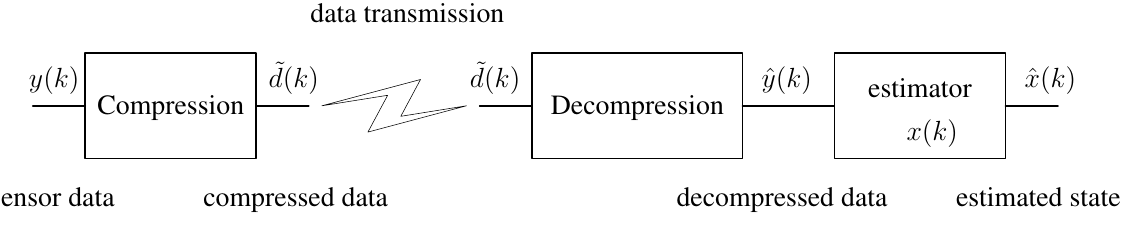
Figure 1. Overview of inertial and magnetic sensor data compression and estimation.